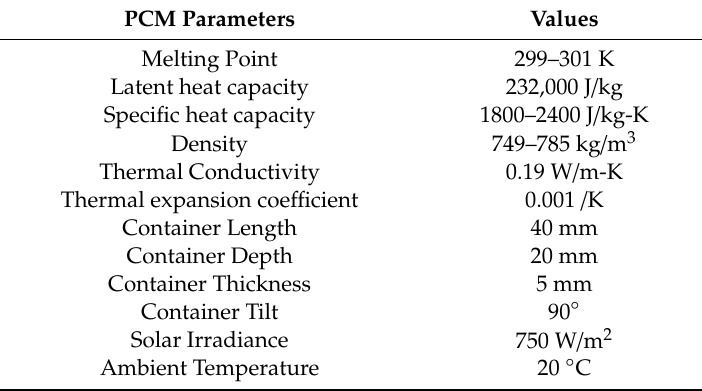
Table 2. Specifications of system for comparison.